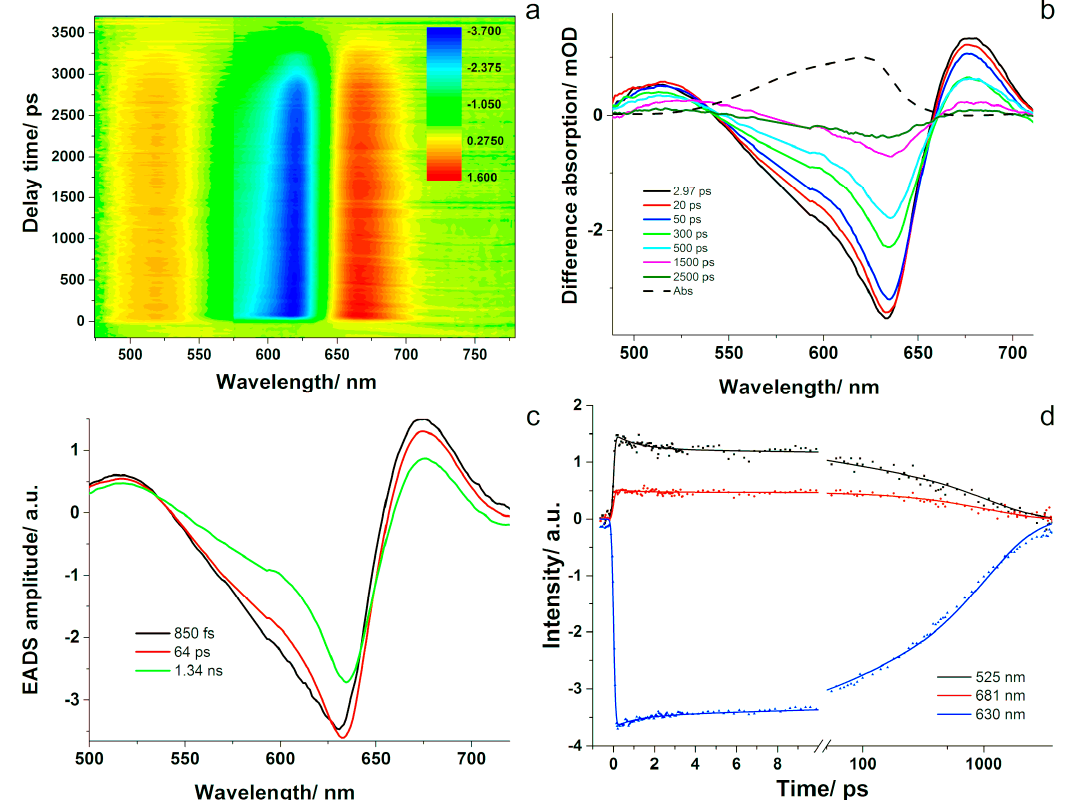
Figure 4. ( a ) 3D transient absorption data carpet obtained from phycocyanin (PC) pumped at 580 nm; ( b ) Transient absorption spectra of PC showing bleach recovery of the ground state as a function of time delay between pump and probe pulses; the UV-VIS absorption spectrum is also given (dashed line); ( c ) The resulting evolution-associated difference spectra obtained with global analysis using three compartments; ( d ) Examples of kinetic traces together with the fits.